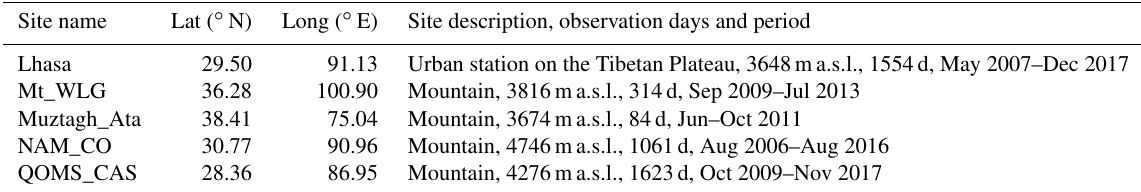
Figure 1. Topography of the Tibetan Plateau (TP) and the five CE318 stations located in the TP (Lhasa, Mt_WLG, Mutztagh_Ata, NAM_CO and QOMS_CAS). Table 1. Site location and